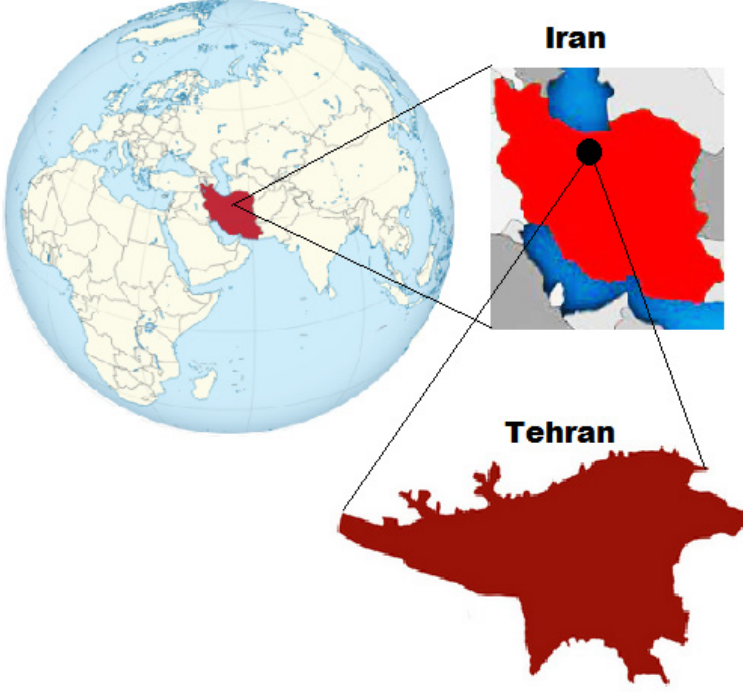
Figure 1. Geographical location of Tehran .